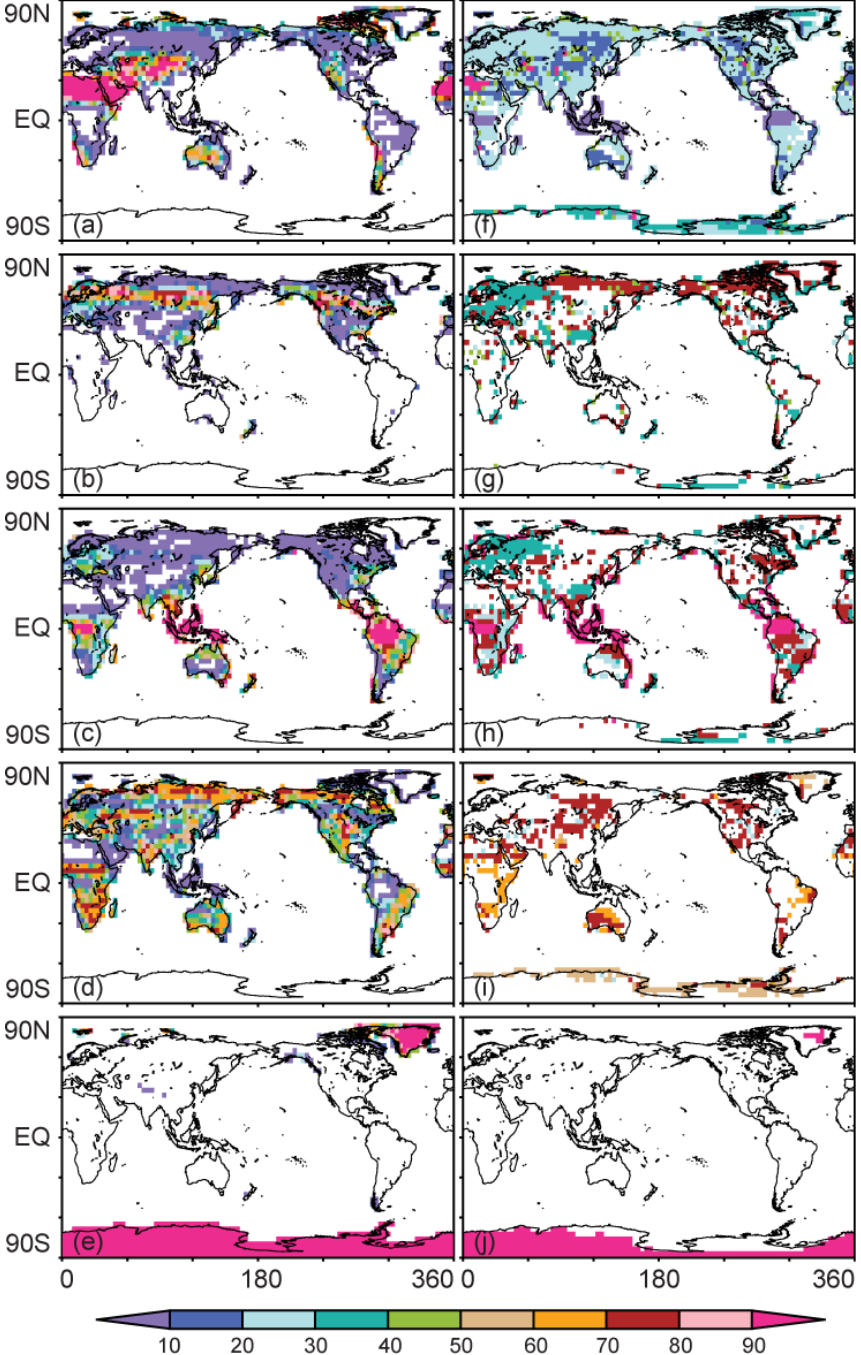
Fig. 3. Pre-industrial and mid-Pliocene land cover conditions (%), left column for the pre-industrial, right column for the mid-Pliocene. (a) and (f) for the percentage of bare land. (b) and (g) for the percentage of needleleaf trees, including needleleaf evergreen temperate tree, needleleaf evergreen boreal tree, and needleleaf deciduous boreal tree. (c) and (h) for the percentage of broadleaf trees, including broadleaf evergreen tropical tree, broadleaf evergreen temperate tree, broadleaf deciduous tropical tree, broadleaf deciduous temperate tree, and broadleaf deciduous boreal tree. (d) and (i) for the percentage of shrubs and grasses, including broadleaf evergreen temperate shrub, broadleaf deciduous temperate shrub, broadleaf deciduous boreal shrub, arctic C3 grass, cool C3 grass, warm C4 grass, and crop. (e) and (j) for the percentage of land